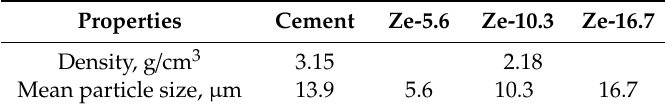
Table 1. Physical properties of cementitious materials.